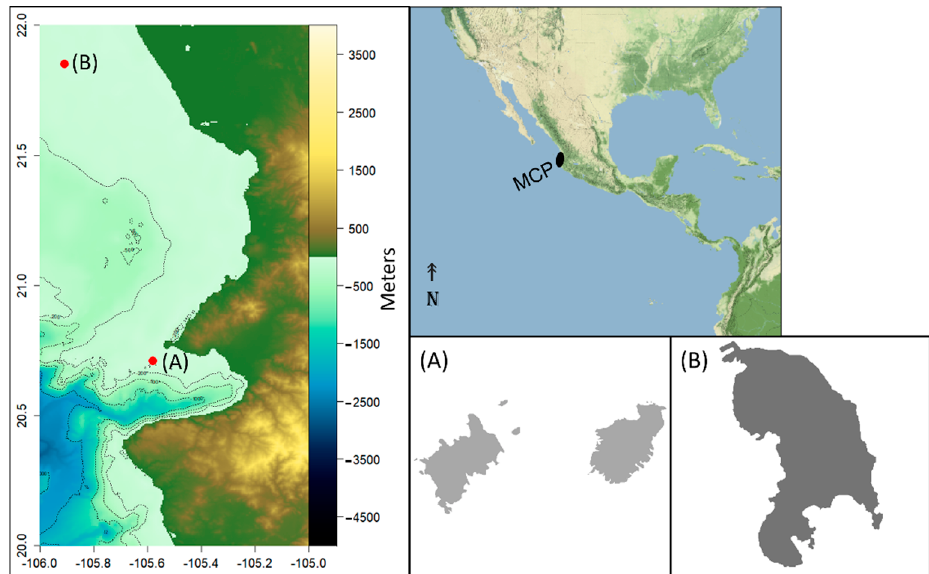
Figure 1. Left panel : GEBCO’S gridded bathymetric and location of the studied insular systems in the central Mexican Pacific, depth in meters. Top right panel : Location of the Mexican Central Pacific (MCP). ( A ) Marietas Islands; ( B ) Isabel Island.